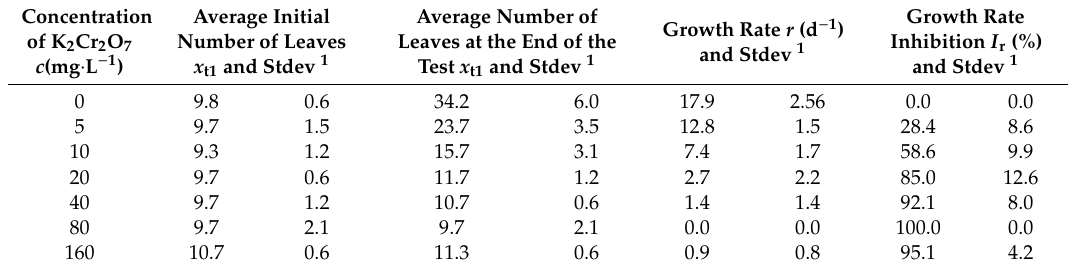
Table 2. Results of the test on the Lemna minor obtained from the counted number of leaves.